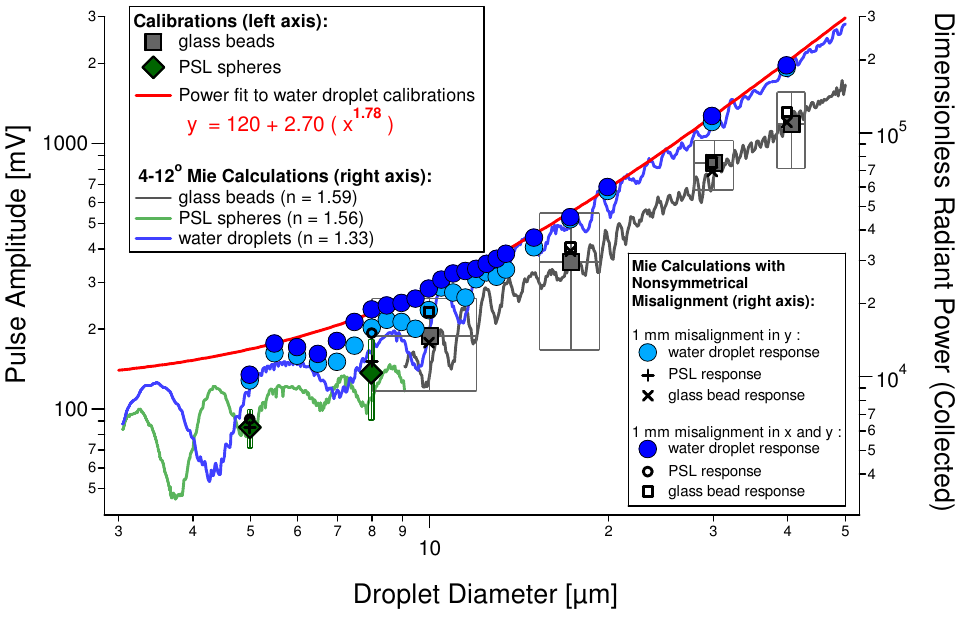
Fig. A4. The calibrated response of the CDP to PSL and glass beads, and the calculated response for PSL, glass beads and water droplets assuming that forward scattered light 4–12 ◦ is collected by the sizing detector. The light blue dots show the modeled CDP response for water droplets given a 1mm misalignment in the y -dimension (laterally across the laser, and perpendicular to the droplet trajectories). The dark blue dots similarly show the modeled CDP response for water droplets given a slightly greater misalignment. The fit to the water droplet calibrations is shown for comparison. The calculated responses to PSL and glass beads (given these two examples of misalignment) are also shown, and often agree well with the PSL and glass bead